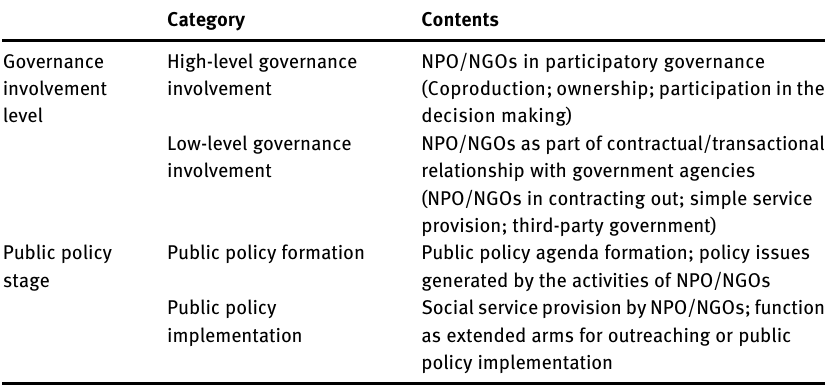
Table  : Thematic classi fi cation of government and civil society partnership.